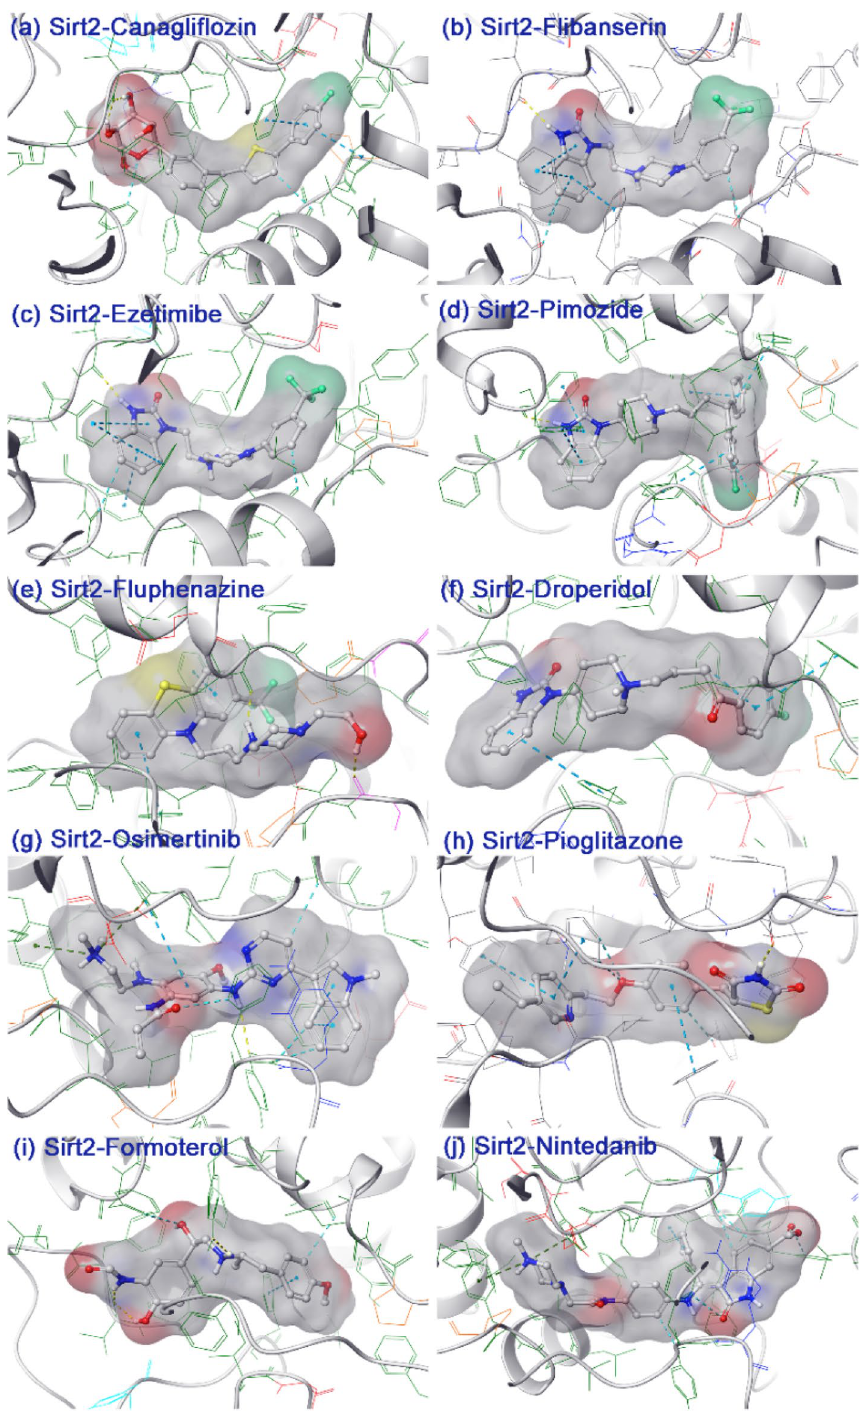
Figure 3.. 3D interaction map for the docked drugs, i.e., ( a ) Canagliflozin, ( b ) Flibanserin, ( c ) Ezetimibe, ( d ) Pimozide, ( e ) Fluphenazine, ( f ) Droperidol, ( g ) Osimertinib, ( h ) Pioglitazone, ( i ) Formoterol, and ( j ) Nintedanib, extracted within 4 Å space around the ligand in the selective pocket of Sirt2. Herein, a ligand surface was generated based on the charge of the atoms in the drug molecules. Academic Schrödinger-Maestro v12.4 suite 43 has been utilized for rendering the images (URL: https:// www. schro dinger. com/ freem